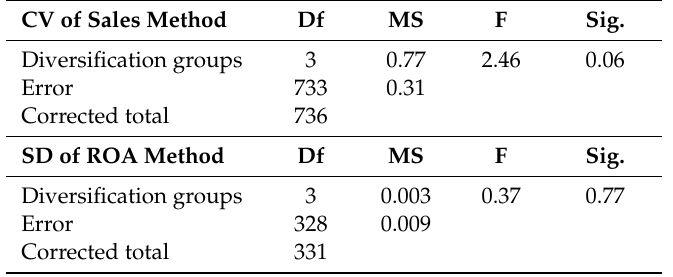
Table 5. Comparison of Analyses of Variance on Diversification Groups, as Related to Corporate